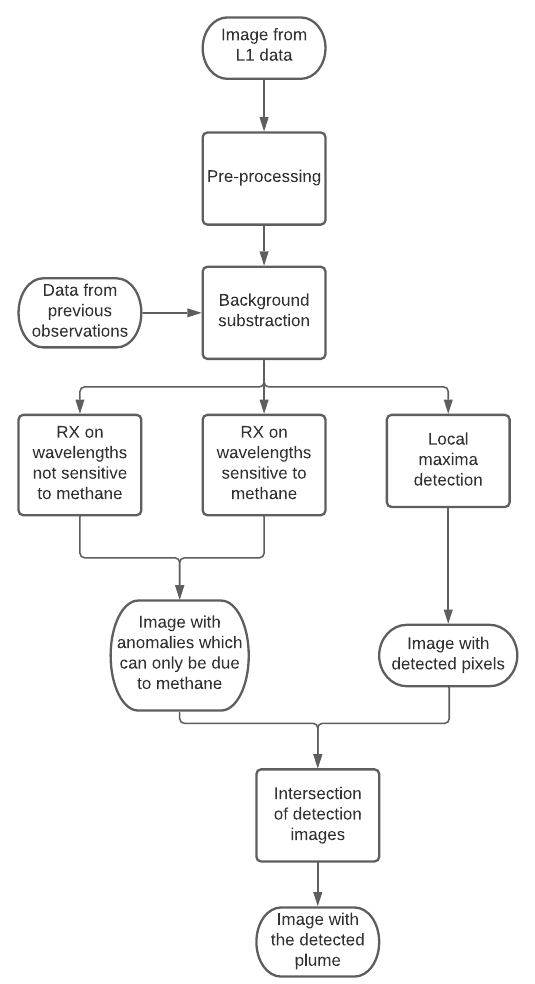
Figure 3. Diagram summarizing the